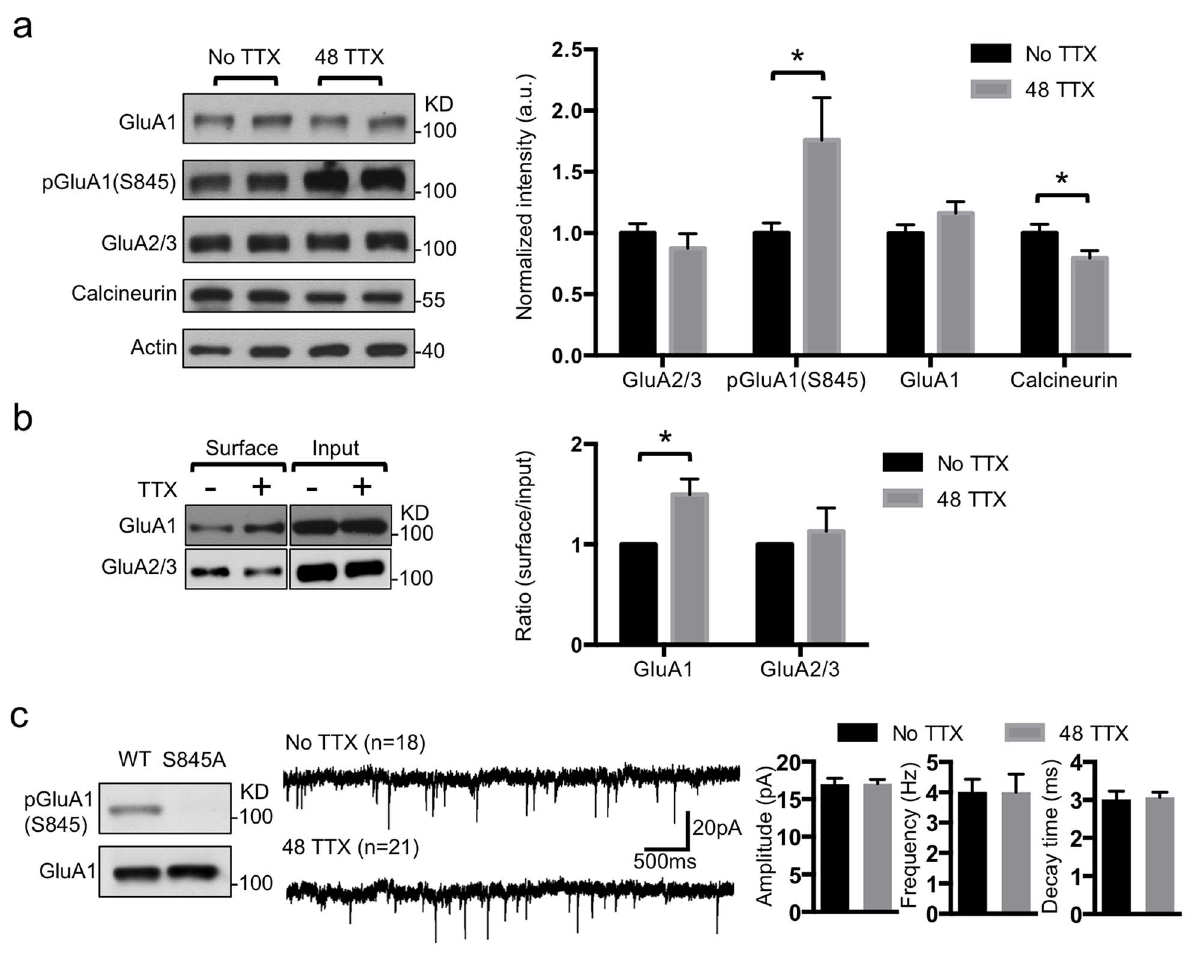
Figure 2. TTX increased GluA1 surface trafficking by phosphorylation but decreased synaptic calcineurin levels. (a) Representative immunoblots and quantitative analysis of synaptosomes from cultured cortical neurons in the presence and absence of TTX treatment ( n =6 experiments, * p , .05, unpaired two-tailed Student’s t test). (b) Representative immunoblots of surface biotinylation and a summary graph in the presence and absence of TTX treatment ( n =3 experiments, * p , .05, unpaired two-tailed Student’s t test). (c) Representative immunoblots showing deficiency of phosphorylation in GluA1 S845A mutant neurons ( n =3 experiments). Representative traces of mEPSCs in the presence or absence of TTX ( n =number of cells). Average mEPSC amplitude, frequency, and decay time (peak to